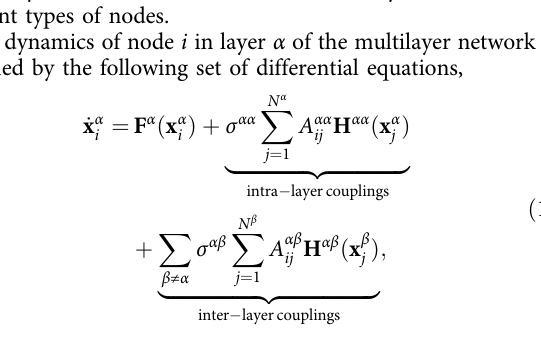
Fig. 1 Illustration of independent layer symmetries and dependent layer symmetries. a A simple two layer network with intra-connectivity described by the matrices A αα and A ββ and inter-connectivity described by the matrix A αβ ¼ ð A βα Þ multilayer network in a . d Example of a dependent layer symmetry for the multilayer network in a